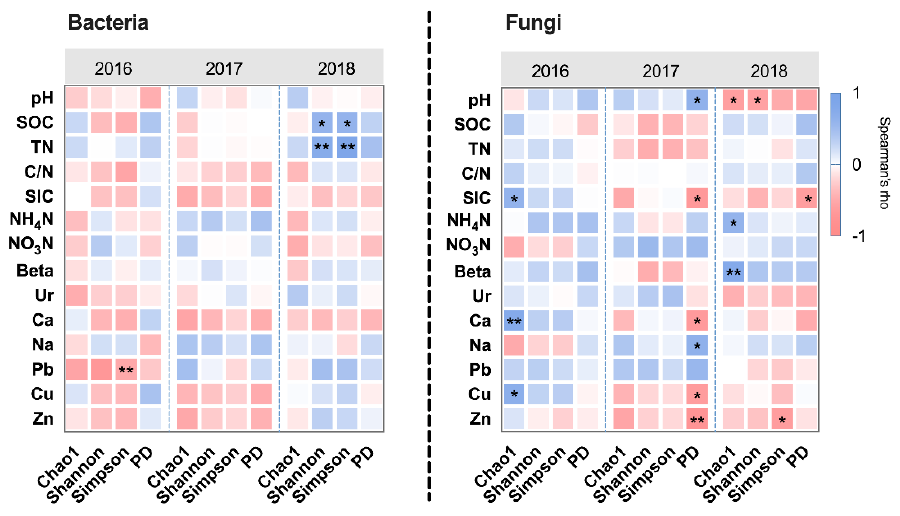
Figure 1. The correlation between soil properties and microbial alpha diversity in each year, based on Spearman’s Rank correlation analysis. *, ** are used to show statistical significance at the 0.05, 0.01 levels, respectively. The colors indicate the values of Spearman’s rho.